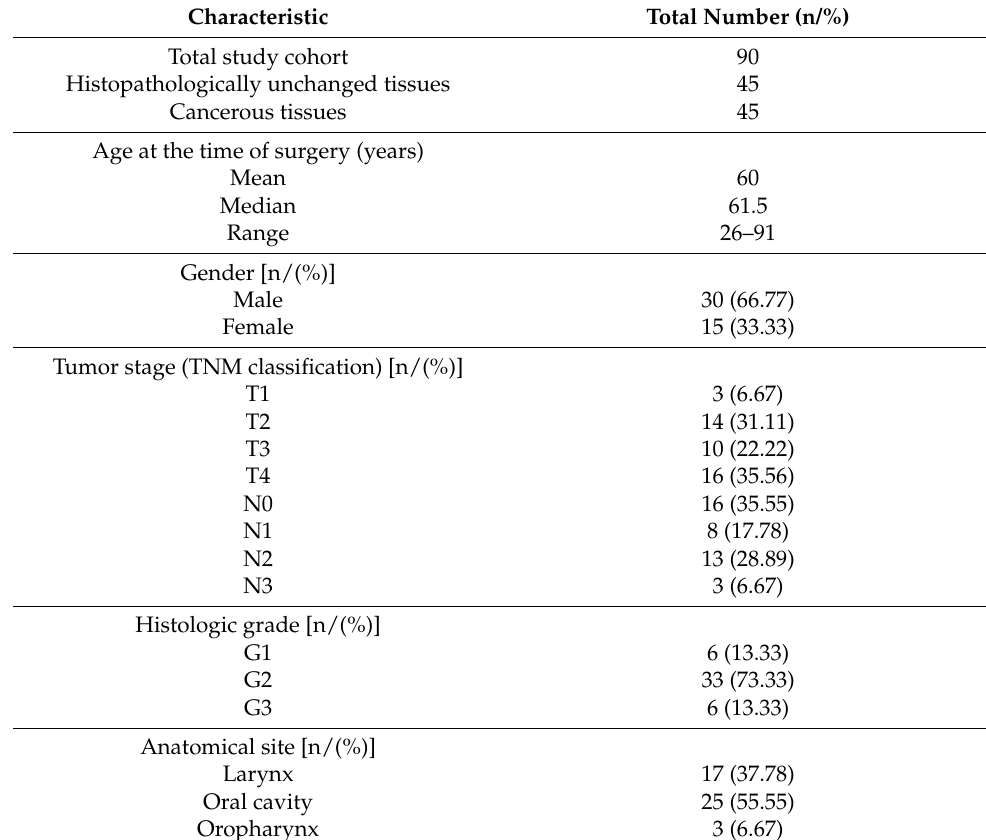
Table 1. Characteristics of the study